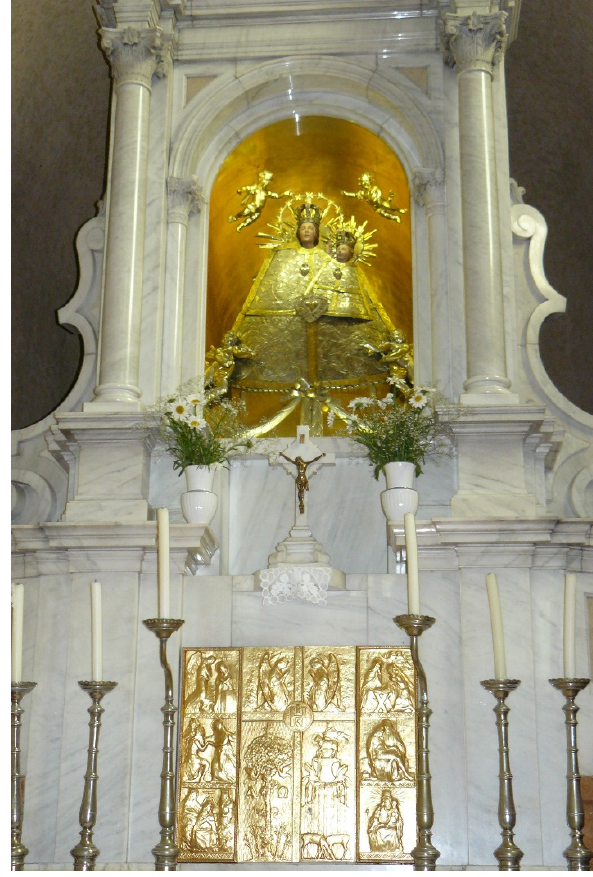
Figure 4. The Virgin Mary of Máriagy ű d, Photo taken by Krisztina Frauhammer, 2008. The number of books and prayer slips increased from year to year in all these places over the period examined, and this trend continued. The names used vary: Emlékkönyv (Remembrance Book), Látogatási könyv (Visitors’ Book), Vendégkönyv (Guestbook). Whatever the name given to the books, they serve not only to record a visit to the shrine and the date of the visit, but have also become fora for contact with the Virgin Mother, Jesus or other saints.